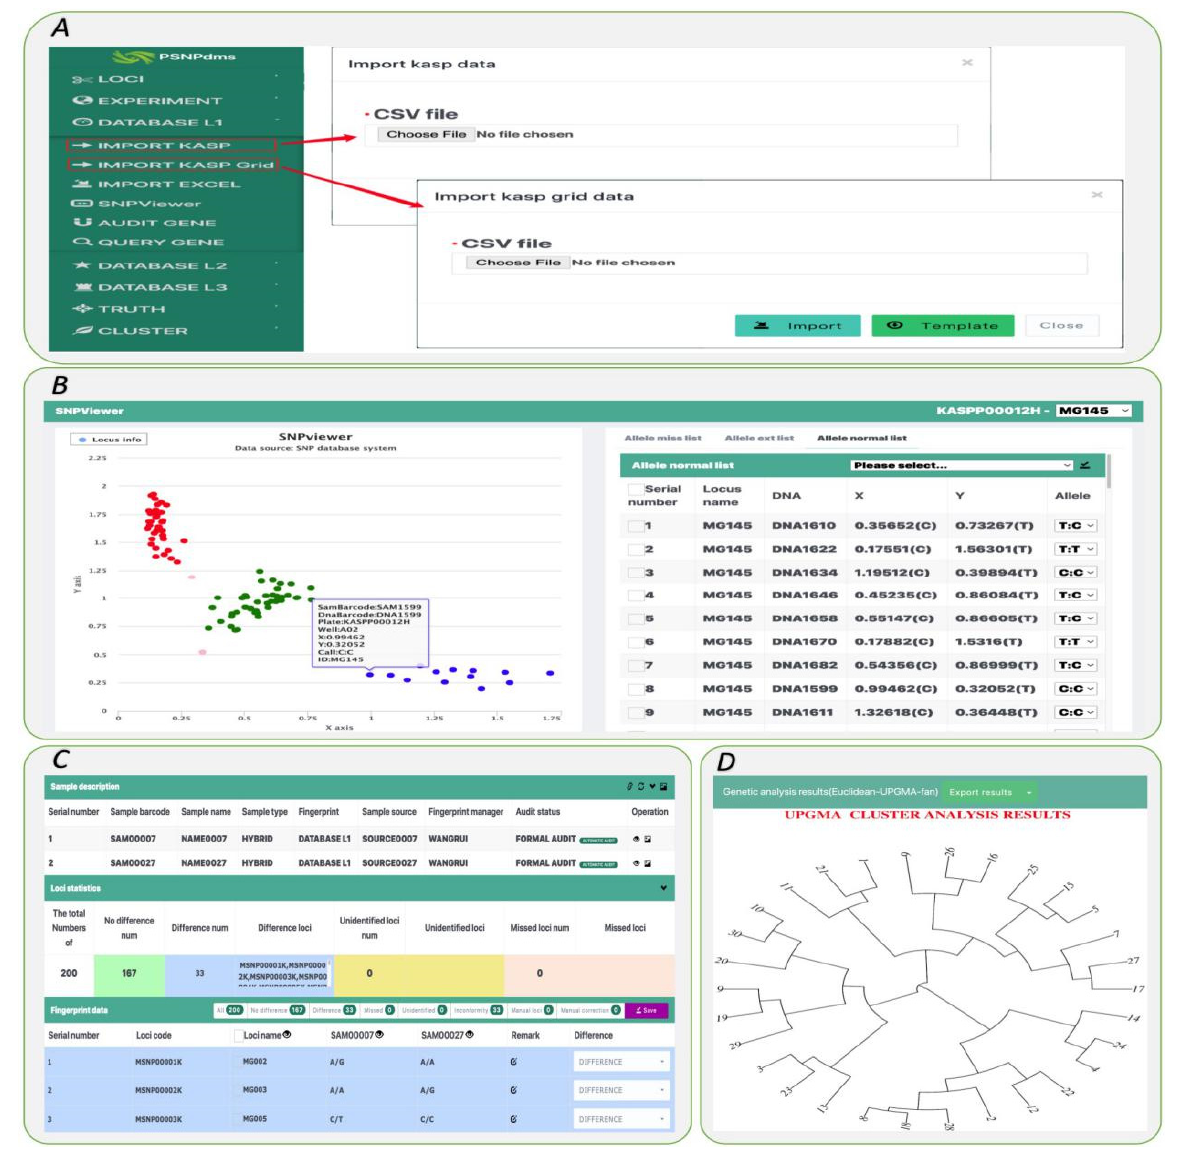
Figure 5. PSNPdms interface and representative workflow. ( A ) The user can import KASP experimental data. ( B ) The user can graphically display KASP experimental data through the SNPviewer function and can modify genetic locus data. ( C ) The user can view the fingerprint data information of the variety identification result database and modify and store the record information. ( D ) The user can use the standard fingerprint database data to generate a dendrogram from the results of the genetic analysis.